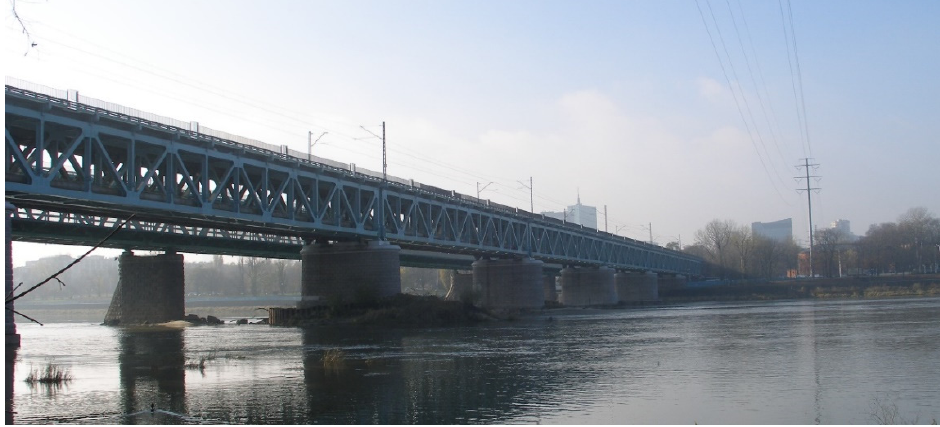
Figure 4. View of bridge No. 1.